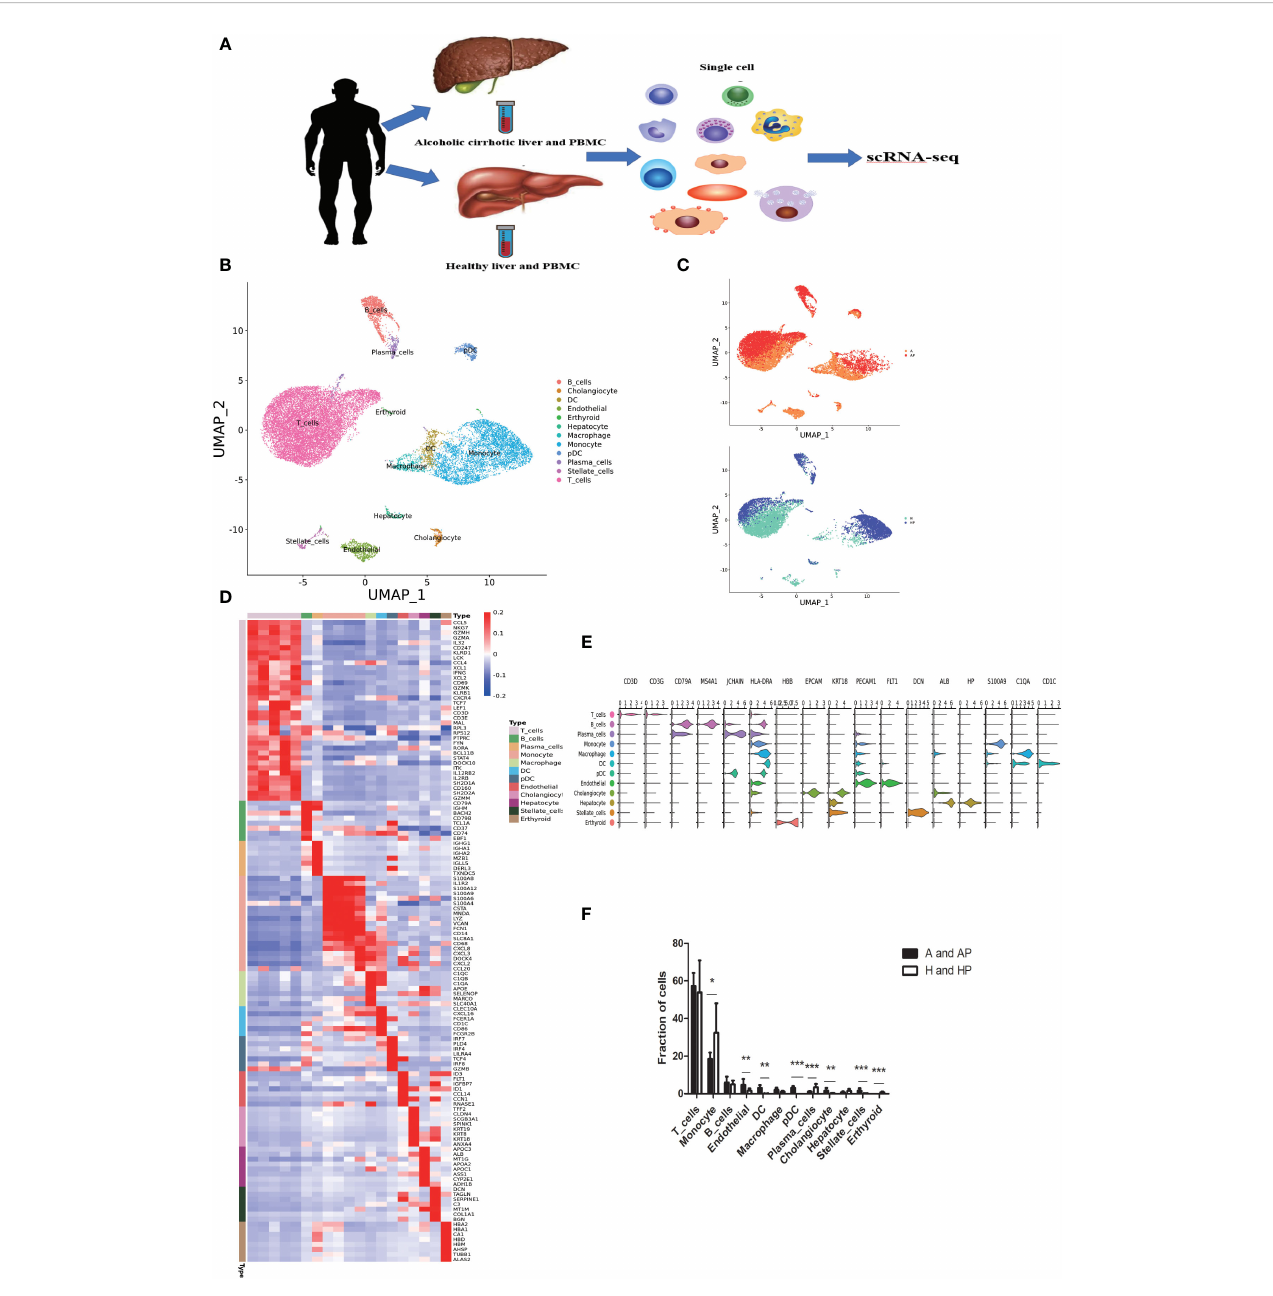
FIGURE 1 Single-cell atlas of human liver non-parenchymal cells (NPCs). (A) An overview of the isolation, FACS, and single-cell sequencing (scRNA-seq) analyses of NPC fractions from liver tissue and peripheral blood mononuclear cells (PBMCs). (B) Clustering of 21638 liver-resident cells and PBMCs from fi ve liver tissue and peripheral blood samples (n = 2 healthy and n = 3 alcoholic cirrhosis) (C) Annotation of the conditions of the patients. (D) Heatmap of cluster marker genes. (E) Scaled gene expression of NPCs cells. (F) Fraction of cells from NPCs. (*P < 0.05, **P < 0.01, ***P <